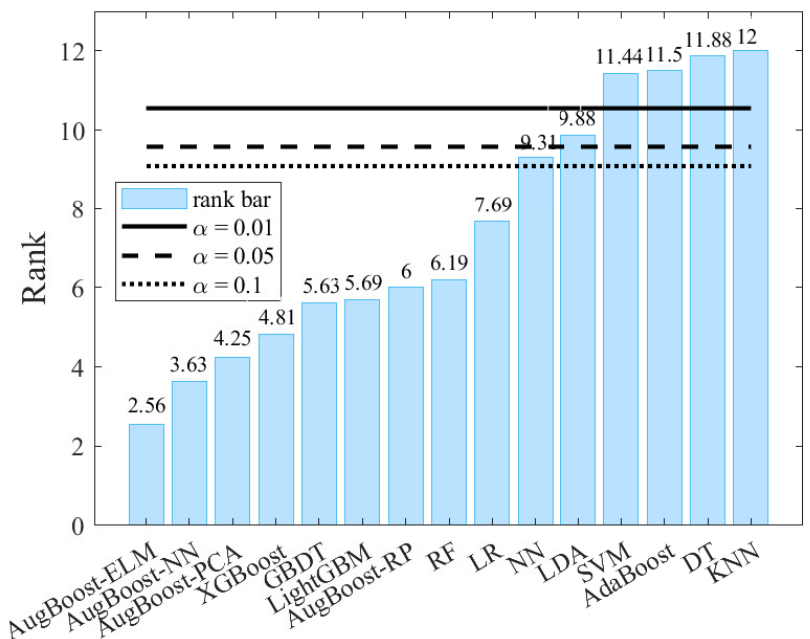
Figure 5. Average ranks of credit scoring models for the Nemenyi test: the black solid line is CD 0.01 + lowest rank , the dotted line denotes the CD 0.05 + lowest rank , and the point line represents CD 0.1 + lowest rank